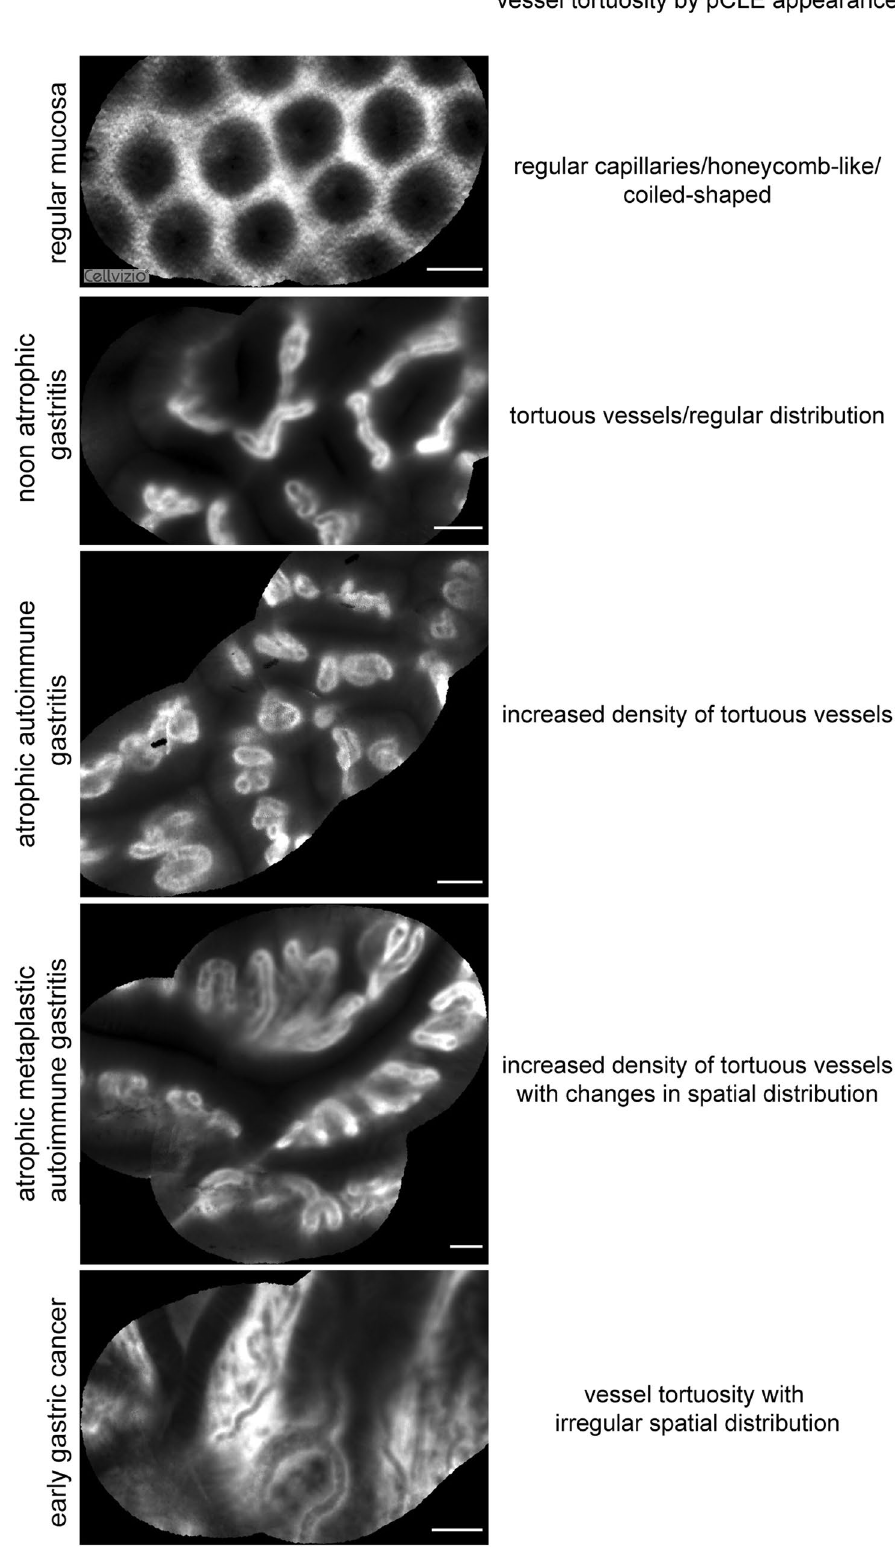
Figure 6. pCLE images of tortuous vessels. Representative mosaic reconstructions obtained from scanned panoramas of the gastric mucosa in healthy (regular mucosa), non atrophic gastritis, atrophic autoimmune gastritis, atrophic metaplastic autoimmune gastritis, and early gastric cancer (EGC) patients. The vessel tortuosity architecture documented by pCLE is described on the right for each patient category. The distribution of tortuous vessels is quite regular in atrophic autoimmune gastritis but in metaplastic patients such distribution is slightly changed. More unstructured vessels with an irregular spatial distribution can be appreciated in EGC patients. Scale bar = 50